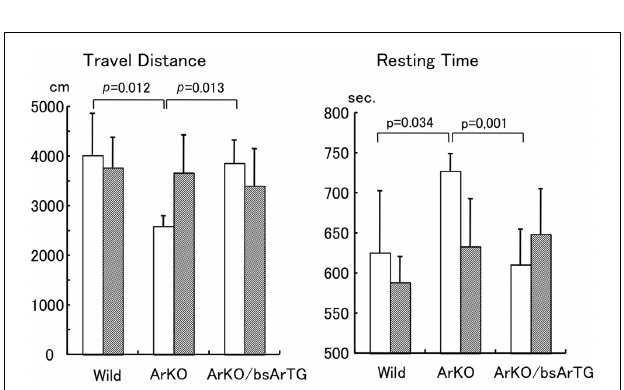
FIGURE 5 |Typical locomotive activities of the wild-type andArKO mice aged 15weeks in open field tests. The locomotive behaviors of wild-type and ArKO mice were monitored in the open field cage (53cm long × 35cm